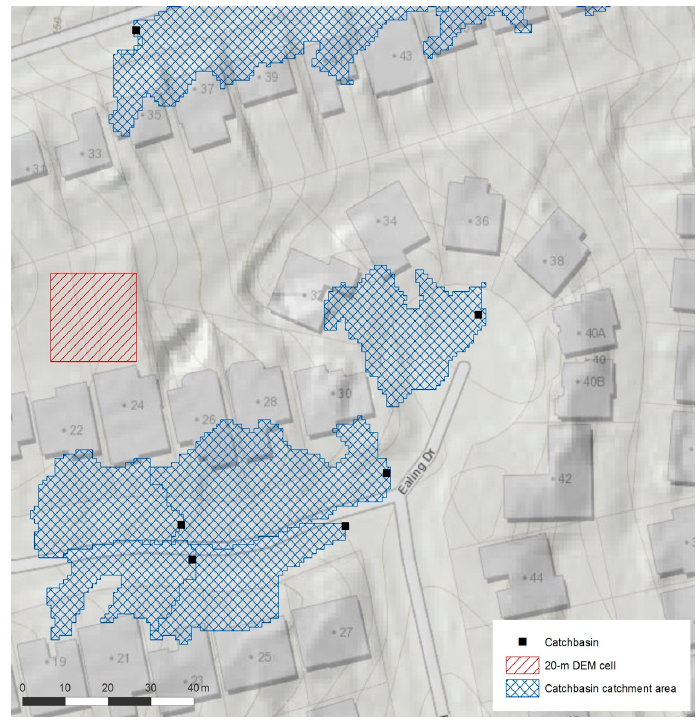
Figure 5. Catchment areas of stormwater drains. The square represents a 20-m pixel.